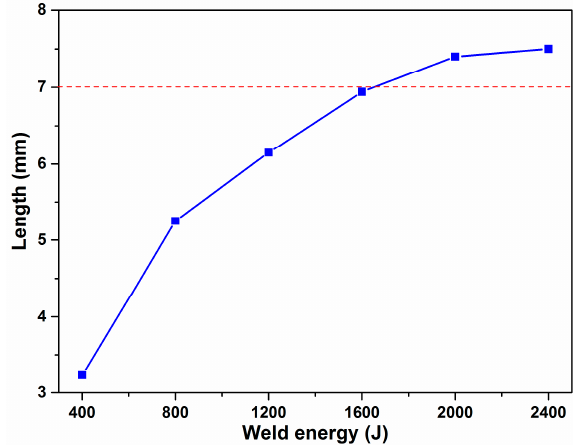
Figure 8. Length of metallic joining in the weld zone as the welding energy increased.